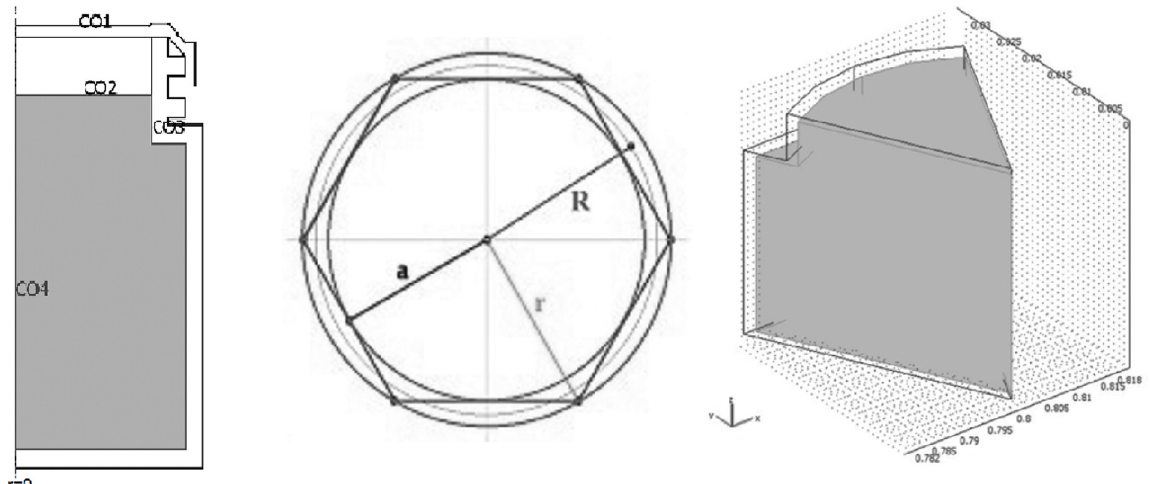
Figure 3. (a) 2D domain with axial symmetry representing the hexagonal container containing the low-calorie grape jam, accompanied by geometric detail of the radius (r) of the circumference that inscribes the vertical projection of the hexagonal container and the radius (a) corresponding to the inner circumference tangent to the faceted faces of the container; (b) Representative 3D domain of 1/6 of the hexagonal container containing the low-calorie grape